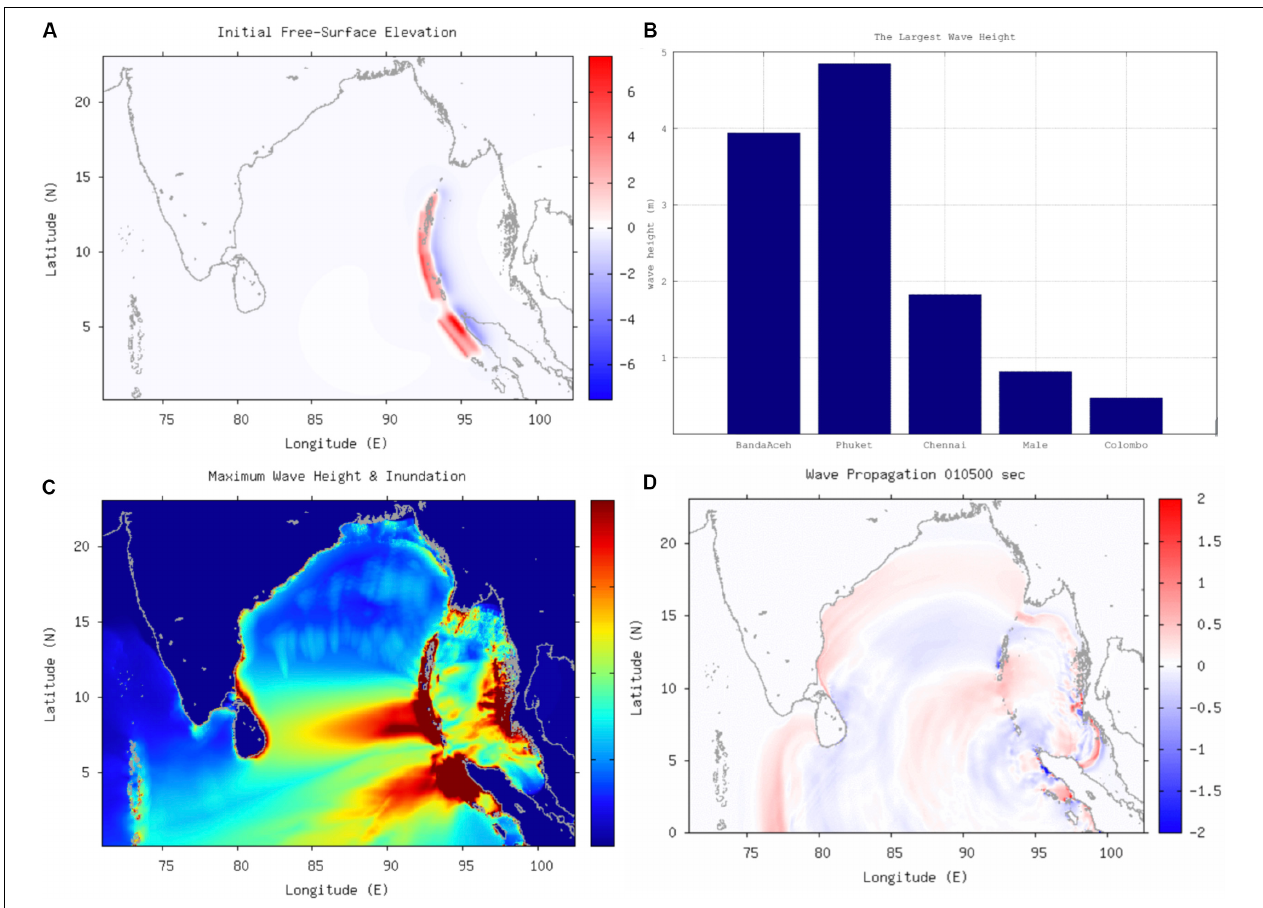
FIGURE 3 | iCOMCOT simulation results of the experiment on the 2004 Indian Ocean earthquake and tsunami simulation experiment: (A) initial free surface elevation; (B) largest wave heights; (C) maximum wave height and inundation; (D) wave propagation